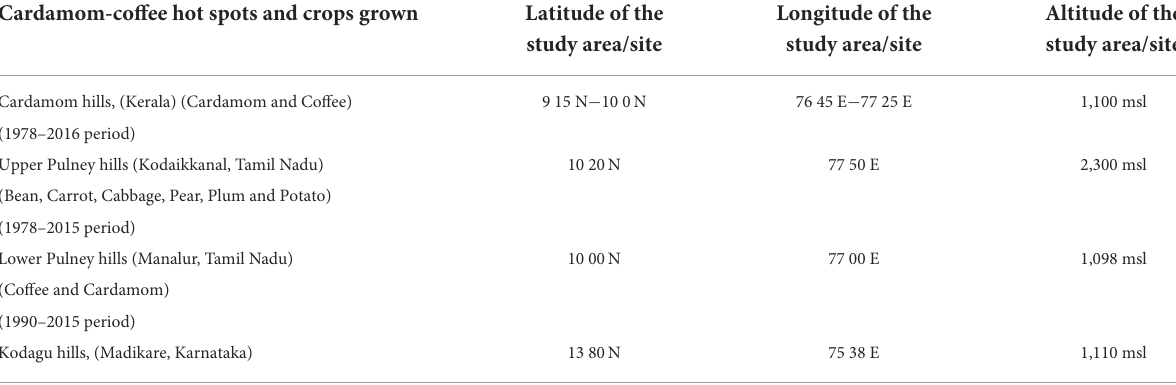
TABLE 1 Name of the metrological station and geographical location details of cardamom-coffee hot spots. Cardamom-coffee hot spots and crops grown Latitude of the